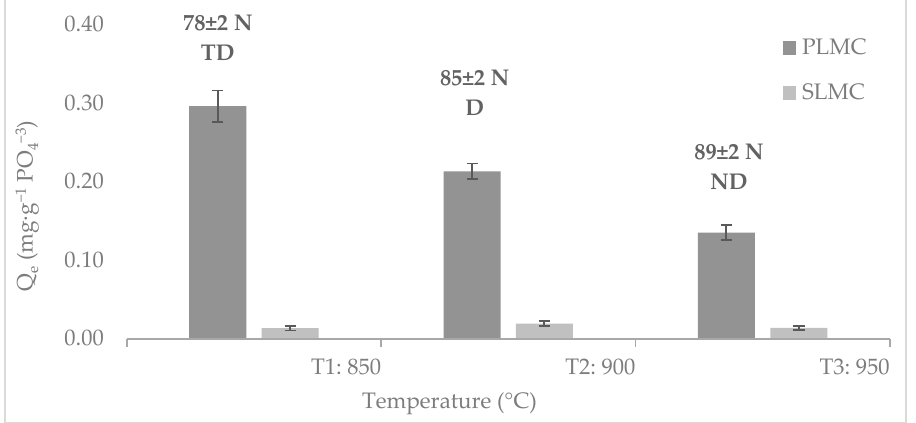
Figure 5. Phosphate adsorption capacity and resistance force of adsorbents as a function of calcination temperature of composites. Parameters obtained at V: 25 mL, w: 0.25 g and C i : 10–2000 mg·L − 1 PO 43 − ; except for SLMC, w: 10 ± 0.2 g was used.